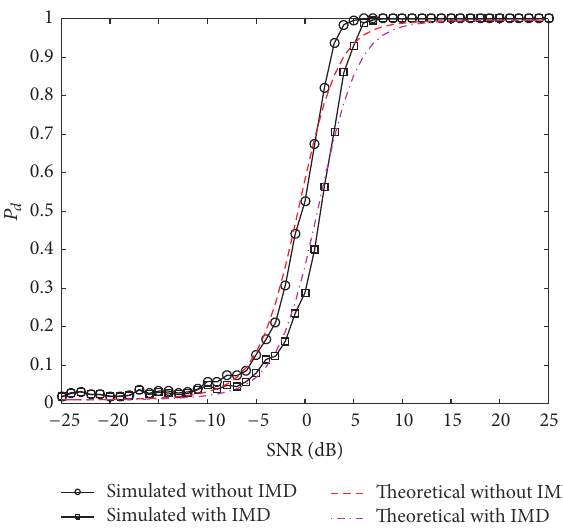
Figure 5: 𝑃 𝑑 versus SNR with IMD of 2dB and 𝑁 = 15 .